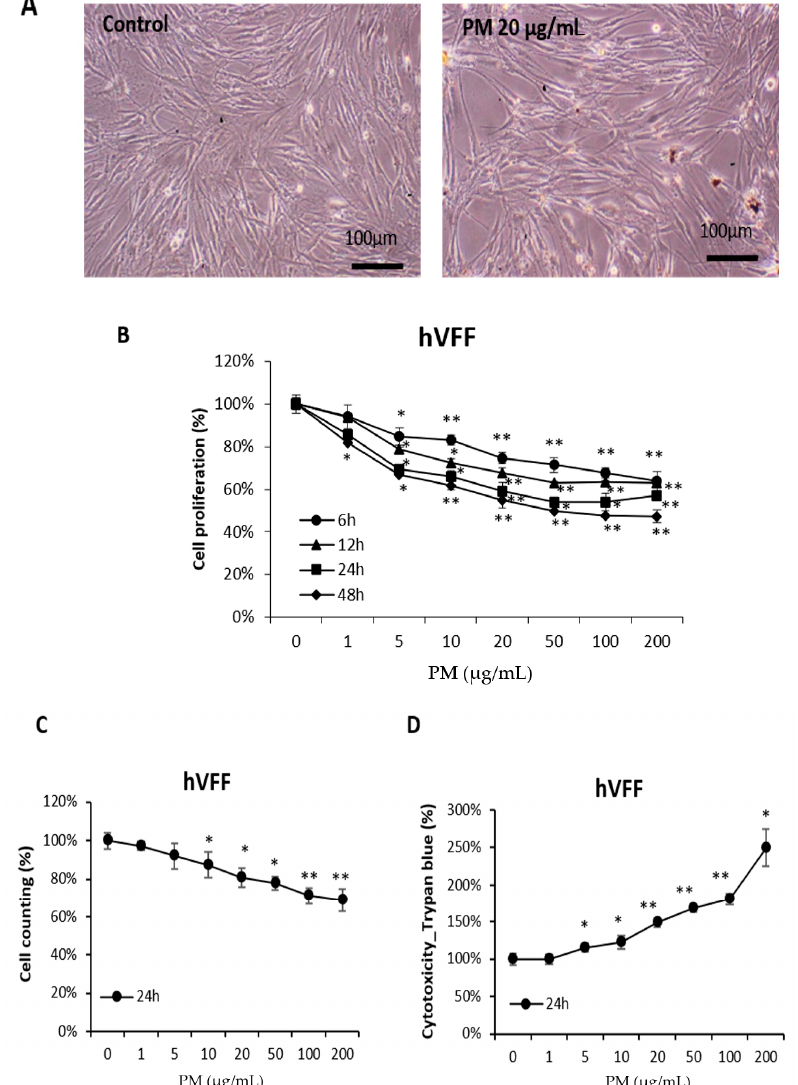
Figure 1. E ff ects of PM on the viability of hVFF. ( A ) Microscopic evaluation of cell morphology. Cells were treated with PM (20 µ g / mL) for 12 h. ( B ) Results of cell proliferation assays. Cells were treated with various concentrations of PM (0–200 µ g / mL) for 6, 12, 24, and 48 h. ( C ) Results of cell counting assays. Cells were treated with various concentrations of PM (0–200 µ g / mL) for 24 h. ( D ) Results of the cell cytotoxic assays. Cells were treated with various concentrations of PM (0–200 µ g / mL) for 24 h. PM induces cytotoxicity in hVFF and decreases cell proliferation. * p < 0.05, ** p < 0.01. 2.3. PM Induces Pro-Inflammatory Cytokines in hVFF through Nuclear Factor- κ B (NF- κ B) Signaling PM induces pro-inflammatory cytokines in cells of the airway mucosa, such as nasal fibroblasts and bronchial epithelial cells, which have been reported to be expressed following the activation of the NF- κ B signaling pathway [6,7,15]. Therefore, the expression of pro-inflammatory cytokines after PM treatment on hVFF was assessed at the messenger RNA (mRNA) level. As the concentration of PM increased, the expression of pro-inflammatory cytokines, such as interleukin (IL)-6 and IL-1 β , increased significantly (Figure 2A). Next, to confirm activation of the NF- κ B signaling pathway by